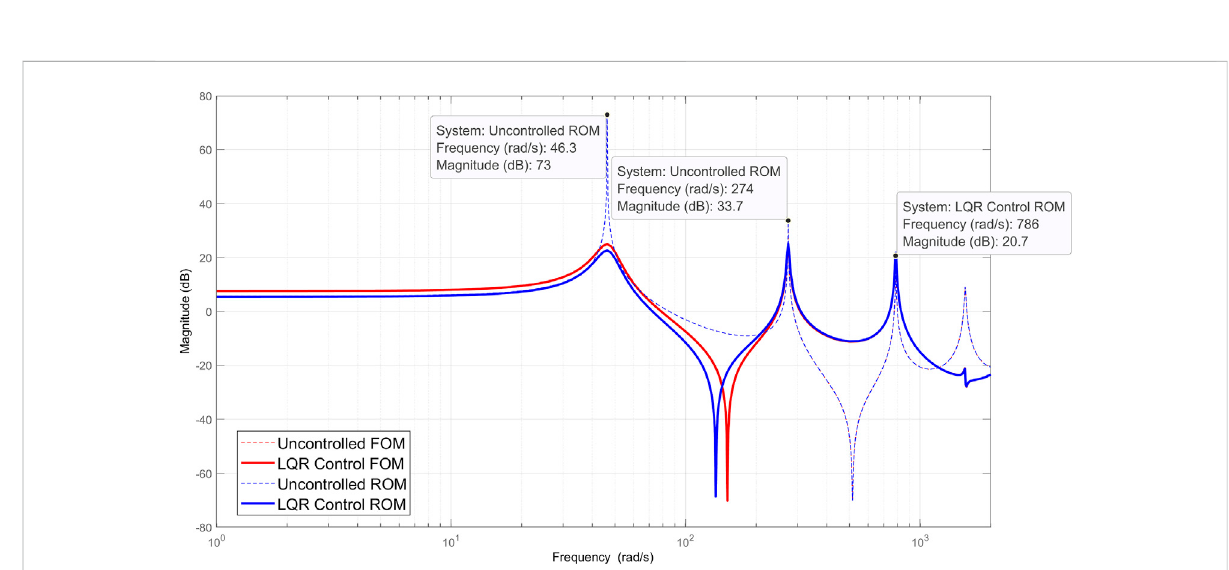
Frequencies of the three fi rst modes in full and reduced models using the LQR control with 46 dofs of 10 distributed